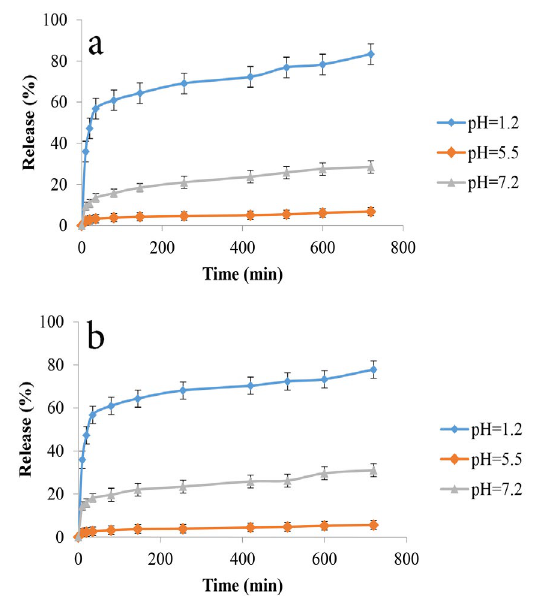
Fig. 6. Atorvastatin release profile from (a) plain polymer and (b) nano-carrier in different pH.